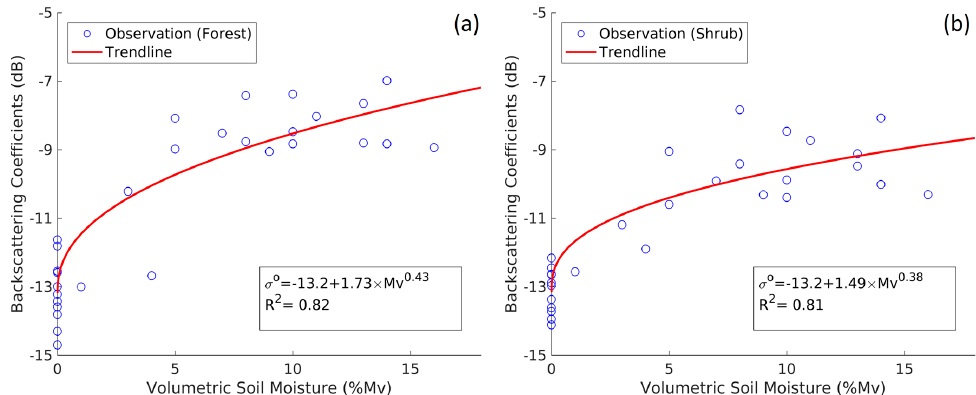
Figure 8. Plot of the change in SAR intensity for forested ( a ) and shrub ( b ) land cover types versus the change in soil moisture measured at the SNOTEL Site Granite Creek (963) (Natural Water and Climate Center (https://wcc.sc.egov.usda.gov)). Data under frozen and unfrozen conditions are included. The third term, exp ( − s/ σ ) , is the decorrelation due to the change in snow depth between two images. The scatterplot of InSAR intensity change (dB) versus snow depth change for soil moisture- free, i.e., winter-winter, interferograms (Figure 5) show no correlation between the SAR intensity change and the snow depth change over forested and shrub landscapes, indicating that snow depth change-induced decorrelation is most likely dominated by the change in the scatterers’ geometry. In Section 4.3, we will perform a statistical assessment to show that the improvement made by considering the snow depth change in the model is statistically significant.